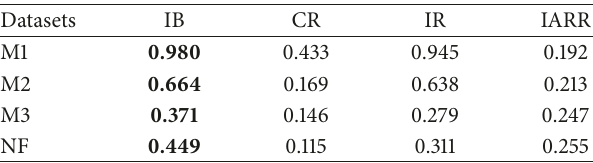
Table 2: The correlation between the users’ reputation scores and their personal MSE values . We apply Kendall’s tau to measure the correlation between the two ranking lists, respectively, generated by ranking users decreasingly according to their reputation scores (the higher, the better) and by ranking users increasingly according to their MSE values (the lower, the better). For each dataset, the highest value is emphasized in bold.